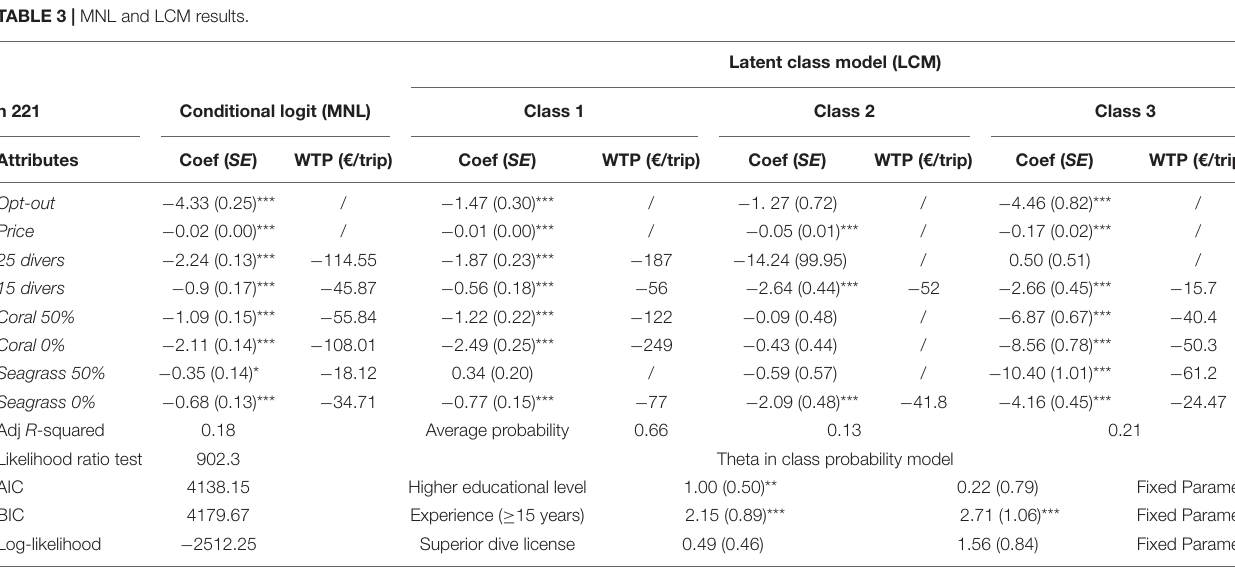
FIGURE 3 | Percentages of diver preferences regarding emblematic Mediterranean marine species. The blue bars represent the responses of beginner divers (open and advanced licenses, N = 79), and the orange bars represent the responses of expert divers (superior dive license, N = 142). TABLE 3 | MNL and LCM